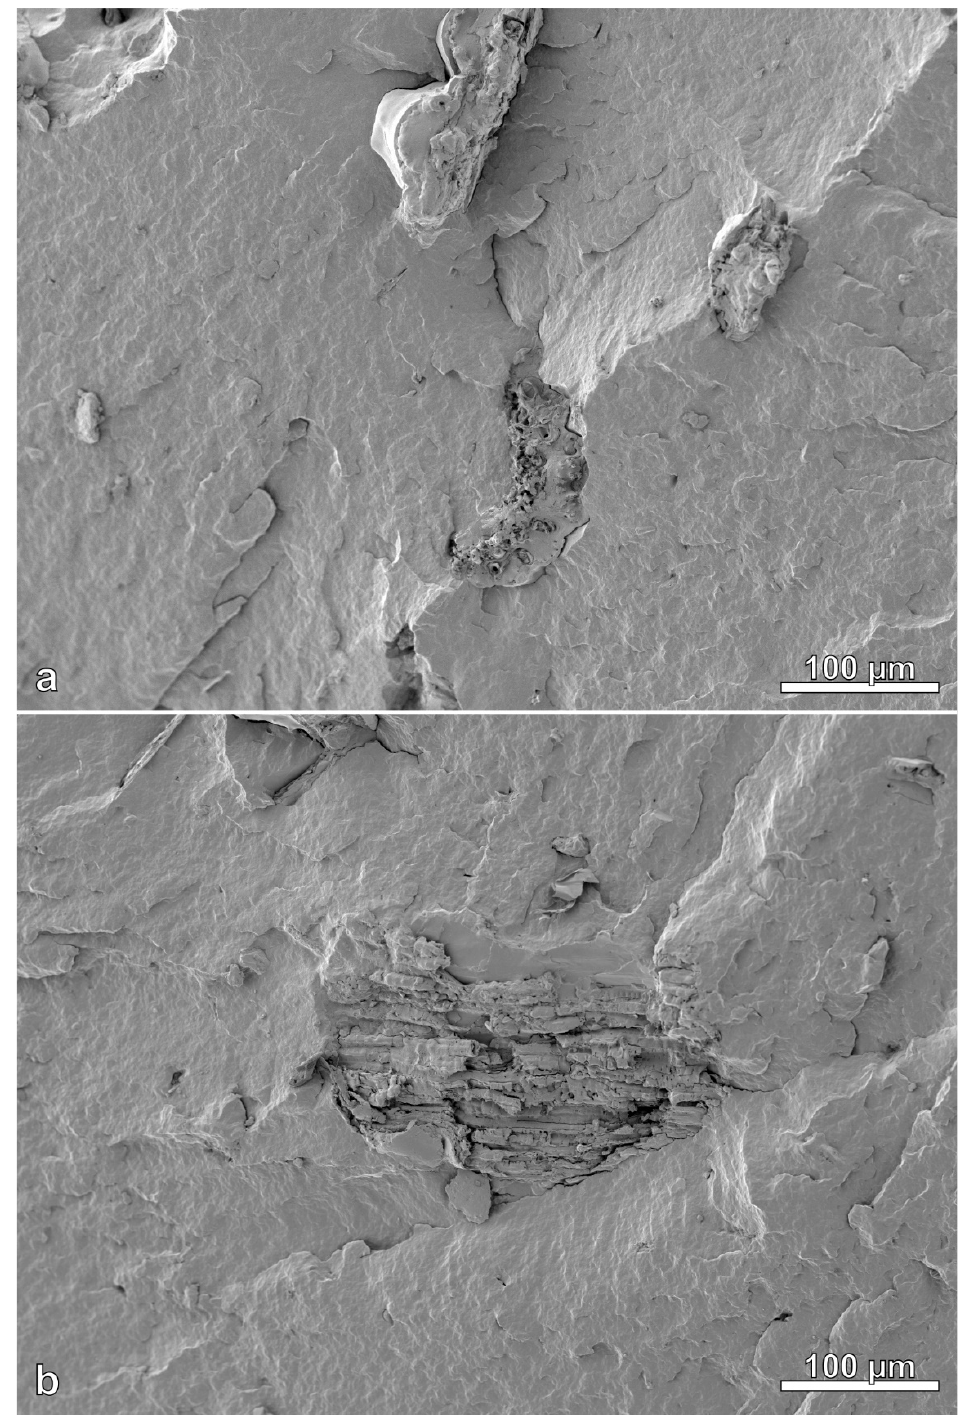
Figure 13. Two images (a and b) of cryo-fractured RRH composite show good adhesion between filler particles and